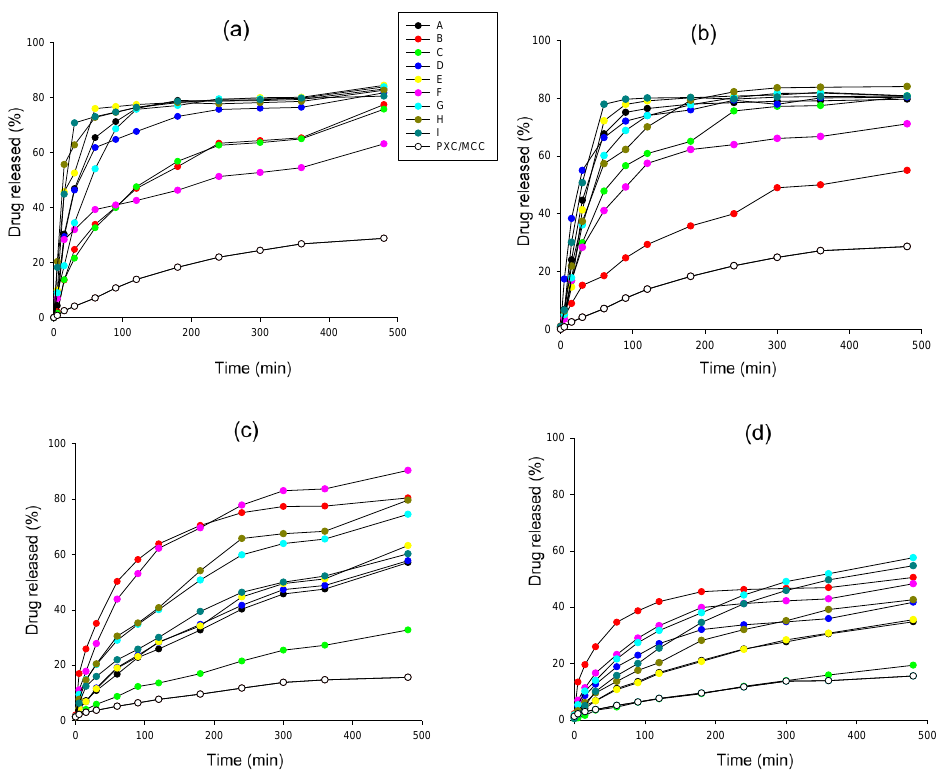
Figure 8. Release profiles of: ( a ) mini pellets at pH 1.2, ( b ) conventional pellets at pH 1.2, ( c ) mini pellets at 5.6, and ( d ) conventional pellets at pH 5.6. Release of drug from pellets prepared without chitosan (PXC/MCC) is also shown for comparison purposes. Batch Α